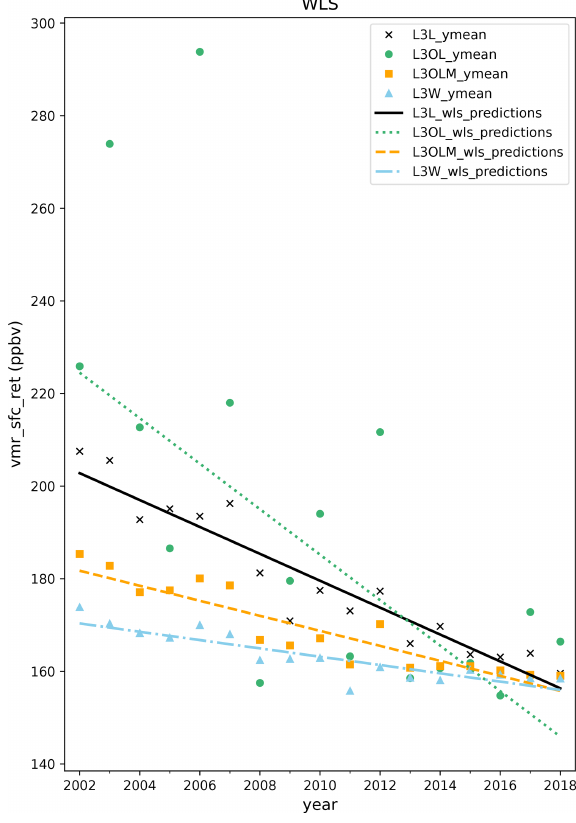
Figure 9. Yearly mean (“ymean” in legend) retrieved VMR in the different datasets being investigated and the trend lines ob- tained from WLS regression analyses on each of these datasets (“wls_predictions” in legend). Black crosses and solid black lines correspond to L3L; filled green circles and dotted green lines corre- spond to L3O L ; filled orange squares and dashed orange lines cor- respond to L3O LM ; filled blue triangles and dash-dotted blue lines correspond to L3W. Trend values for each dataset are also given in Table